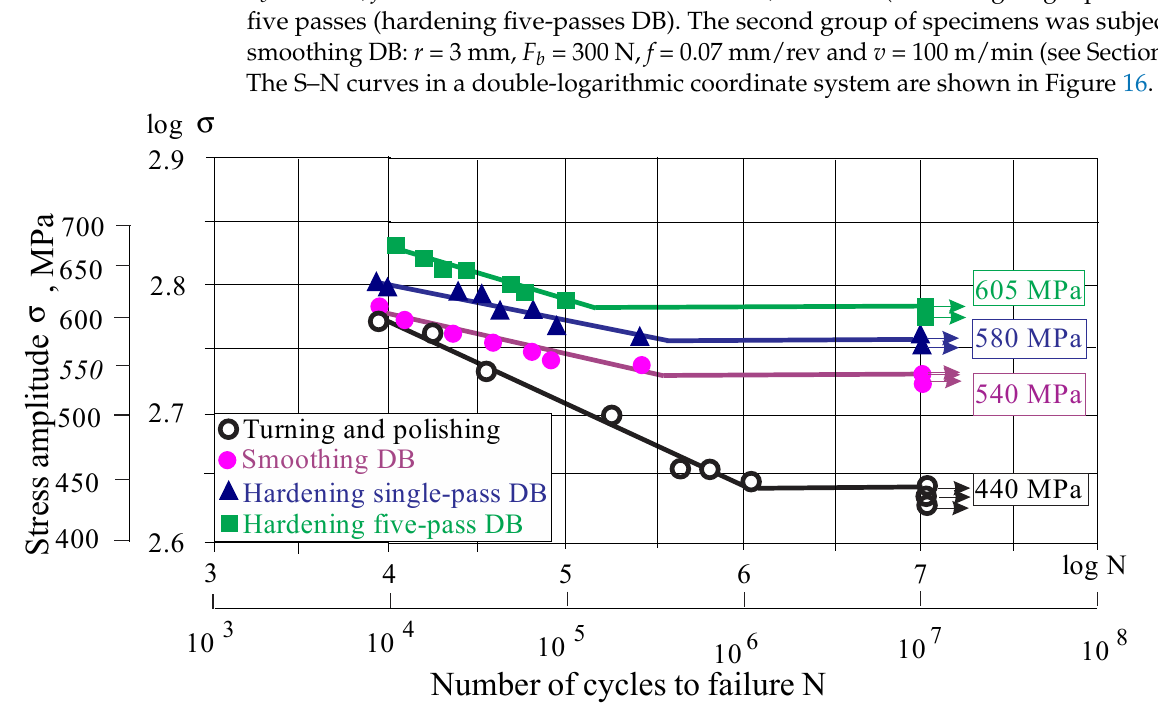
Figure 15. A comparison of the axial residual stresses measured for the austenite phase and obtained via deep rolling [26] and DB.